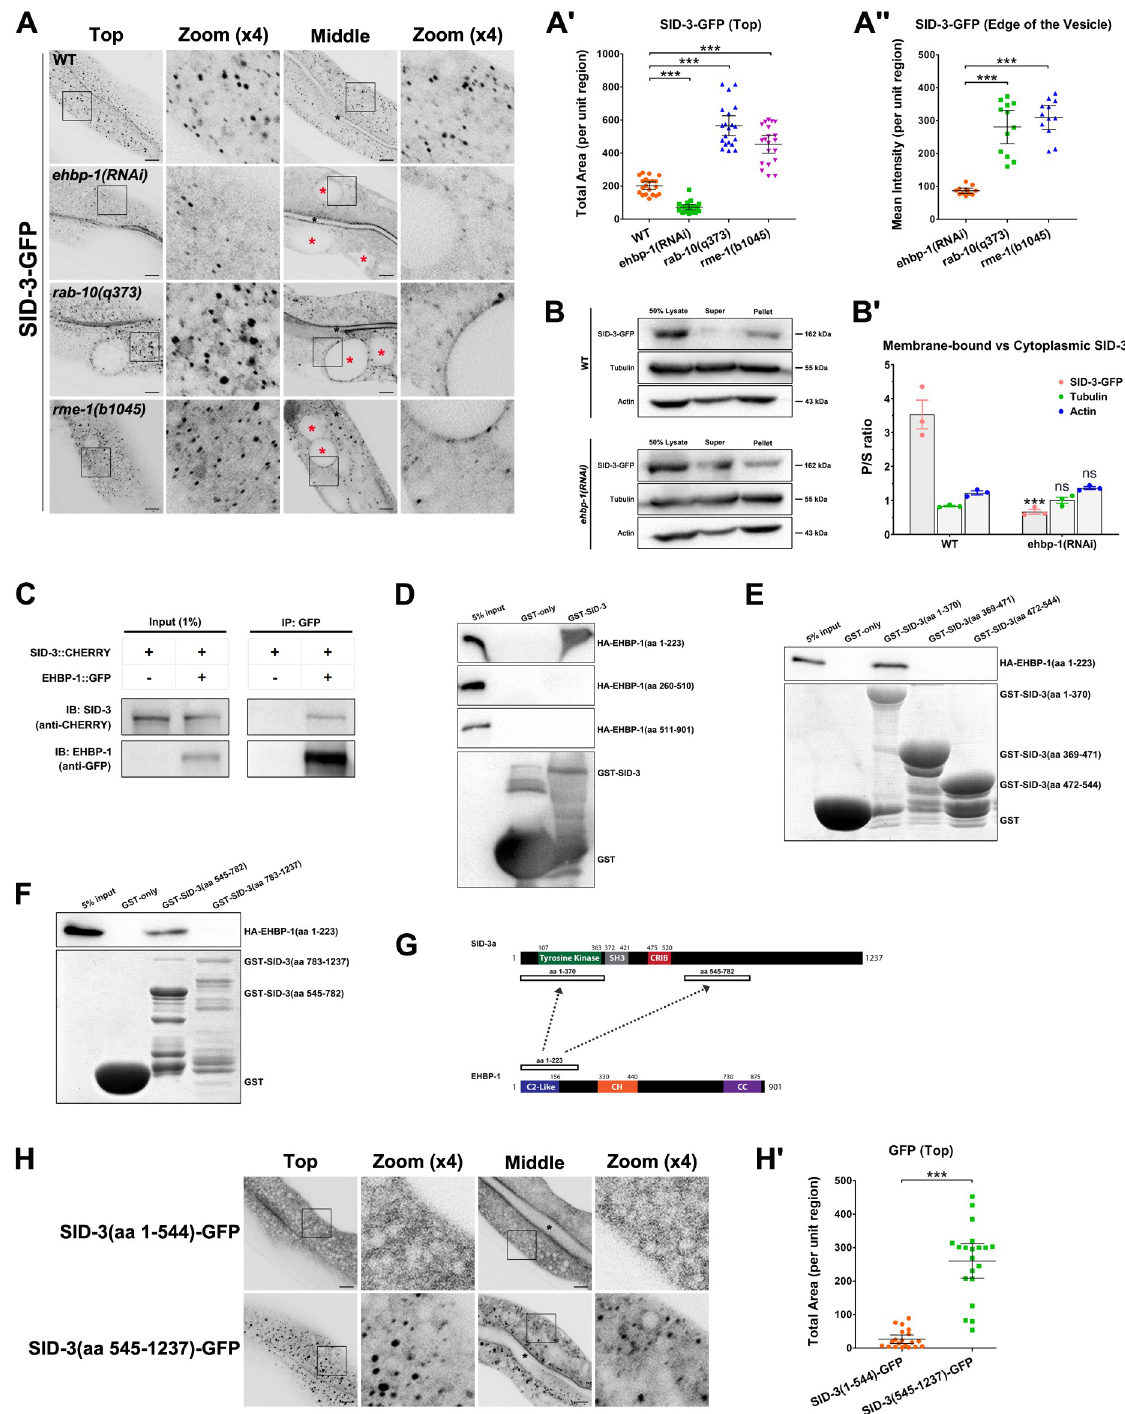
Fig 3. EHBP-1 is required for the endosomal localization of SID-3. ( A-A @ ) Confocal images of the worm intestinal cells expressing SID- 3-GFP. Black asterisks indicate the intestinal lumen. In the top focal plane, SID-3-GFP labeled punctate structures were diminished in ehbp-1 (RNAi) animals. In the middle focal plane, SID-3-GFP failed to decorate the edge of enlarged vacuoles. In rab-10(q373) or rme-1(b1045) animals, SID-3-GFP accumulated on enlarged structures and labeled the vacuoles edges. For A 0 , error bars are 95% CIs (n = 20 each, 10 animals of each genotype were sampled in whole-cell regions of two intestinal cells). For A @ , error bars are 95% CIs (n = 12 each, vacuoles edges were manually selected to obtain the fluorescence mean intensity). Asterisks indicate the significant differences in the Mann-Whitney